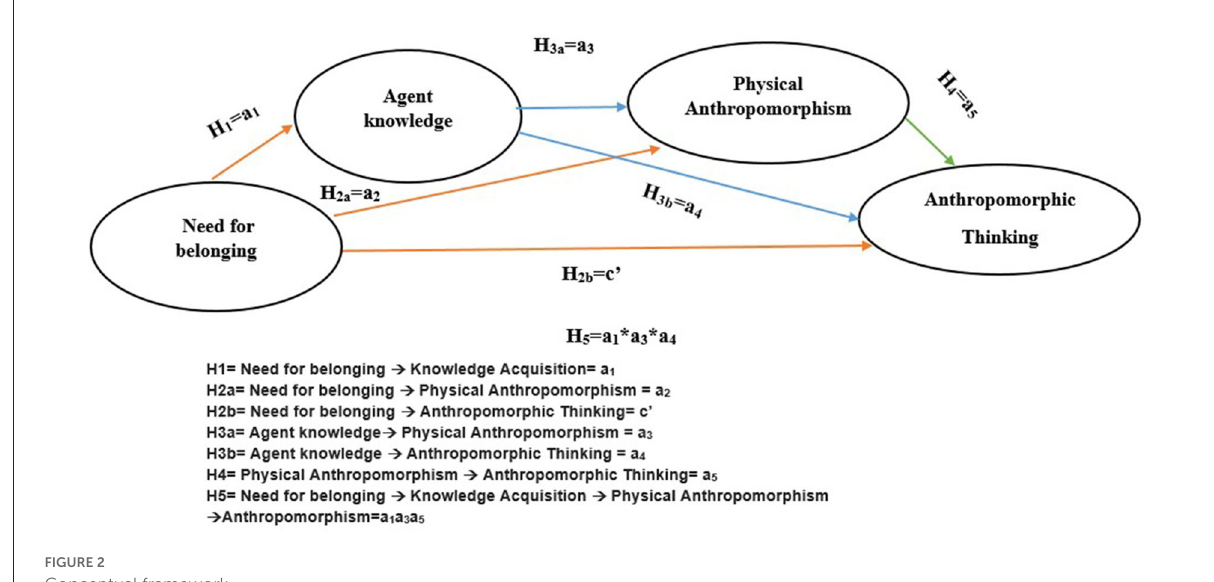
FIGURE2 Conceptual